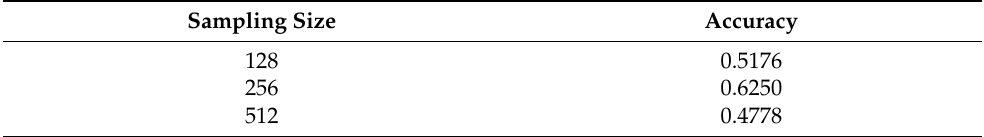
Table 2. Comparison of sampling size with sampling ratios =